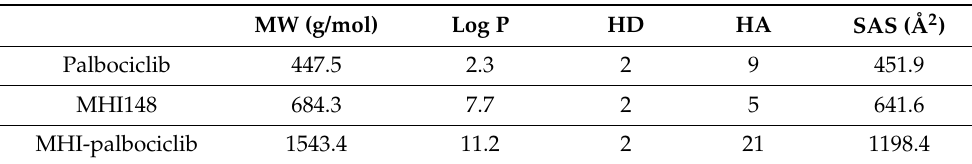
Table 2. The molecular descriptors as calculated by the software